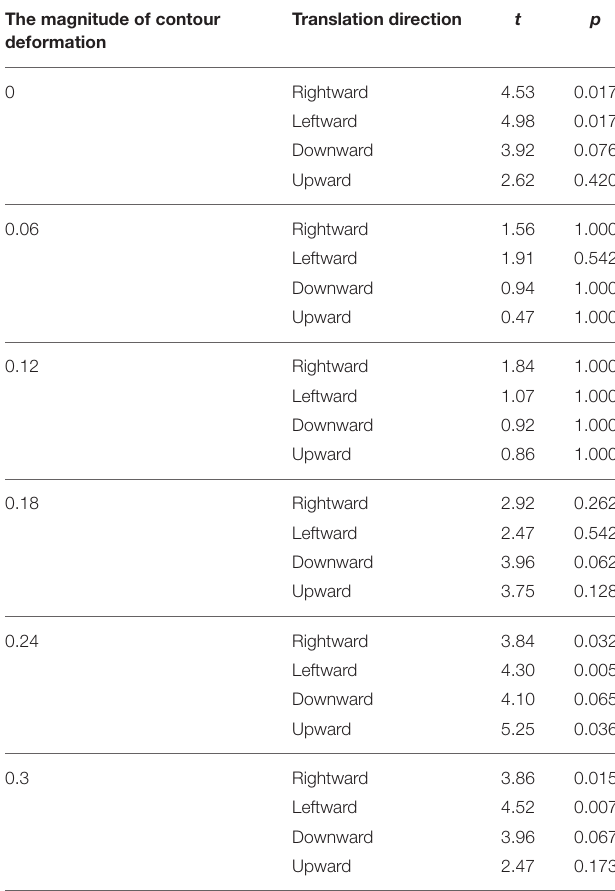
TABLE 2 | The results of multiple comparison tests with the Holm–Bonferroni test between the mean rating score for each level of contour deformation and the value of “3” (the vague impression) in Experiment